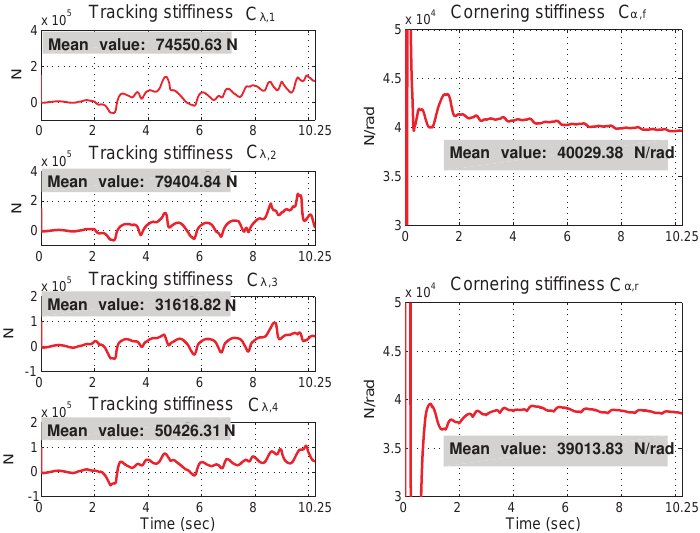
Figure 7. The identification of the tire tracking stiffness and cornering stiffness. The mean values are calculated from the 15th second to the 10th